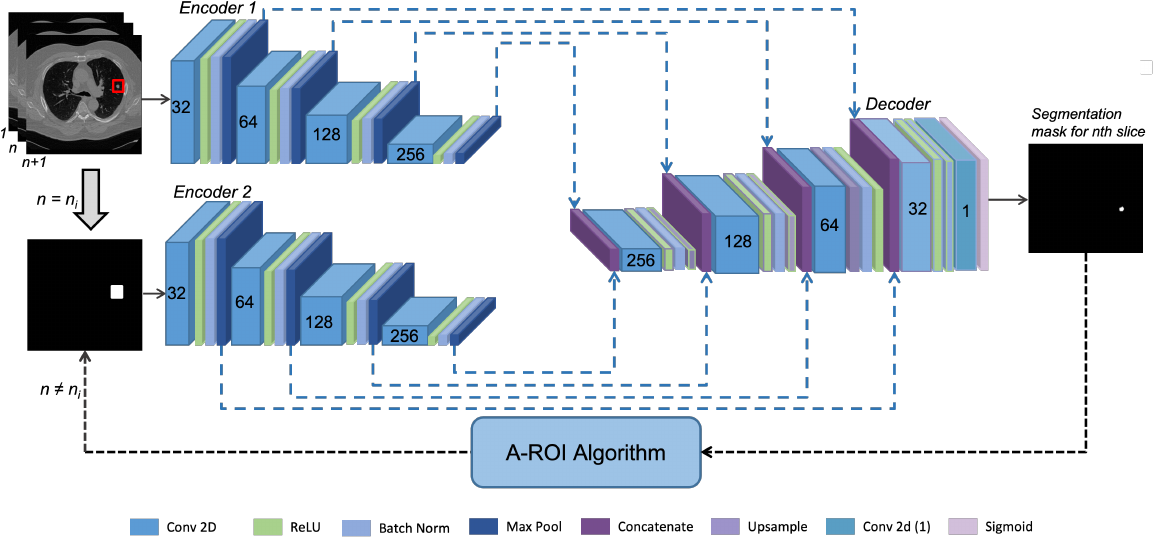
encoder based hard attention network ( DEHA − −